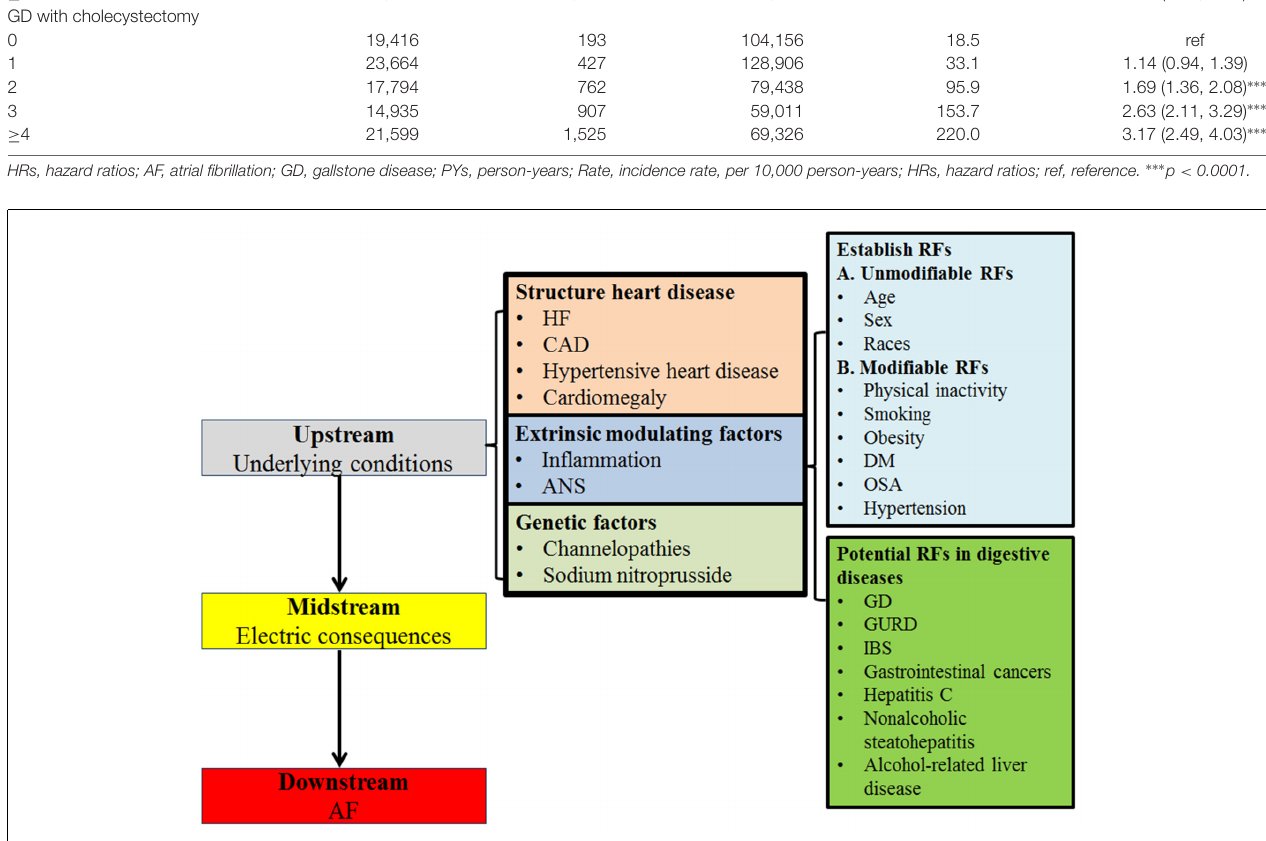
FIGURE 4 | Mechanisms of AF. HF, heart failure; CAD, coronary artery disease; ANS, Autonomic nervous system; RFs, risk factors; DM, diabetes mellitus; OSA, obstructive sleep apnea; GD, gallstone disease; GURD, gastroesophageal reflux disease; IBD, inflammatory bowel